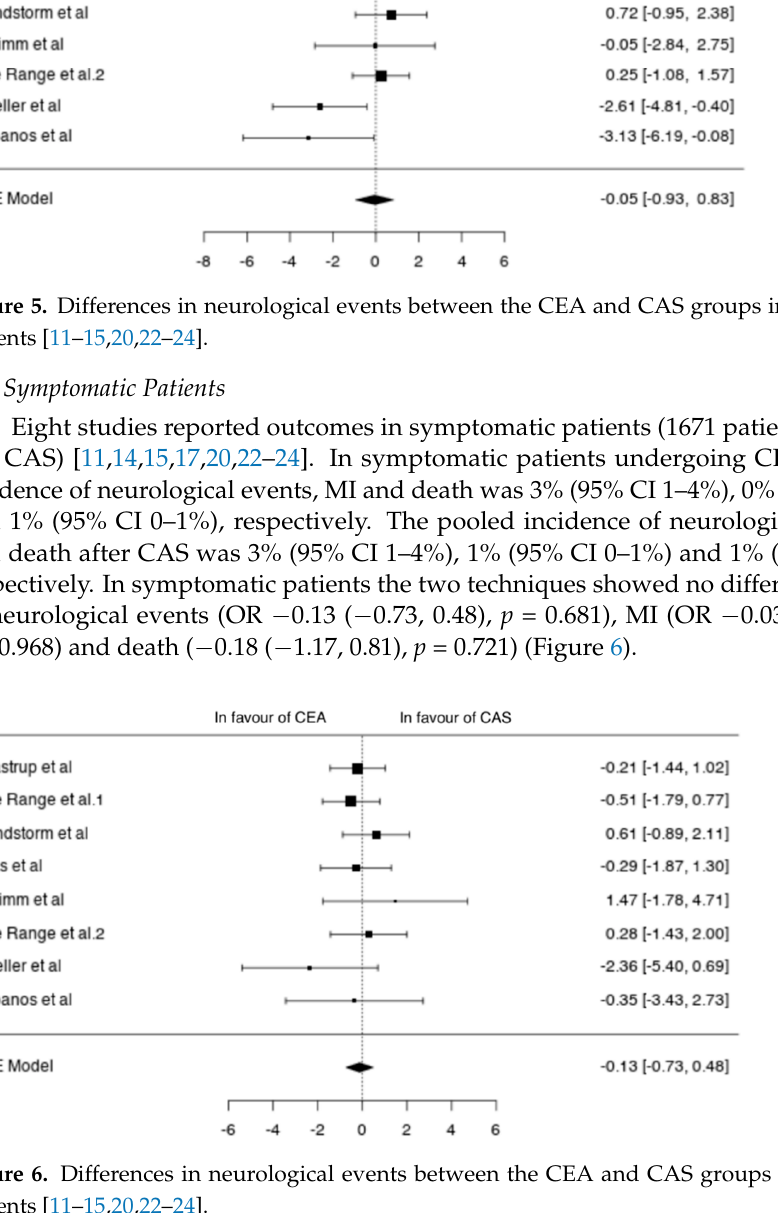
Figure 6. Differences in neurological events between the CEA and CAS groups in symptomatic pa- tients.